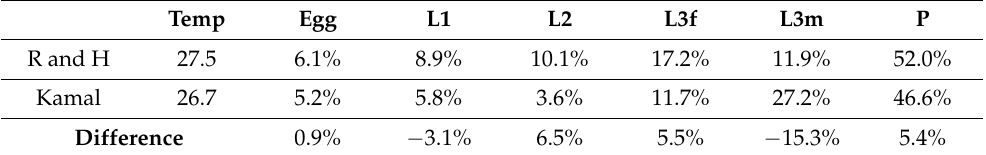
Table 9. Comparison between Kamal [4] and Roe and Higley of Phormia regina as percent in stage. Temp Egg